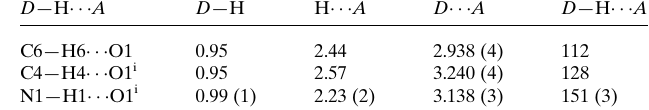
to the a axis for TFMP and the b axis in MOP . There are non- classical carbon-based hydrogen bonds that exist as intra-